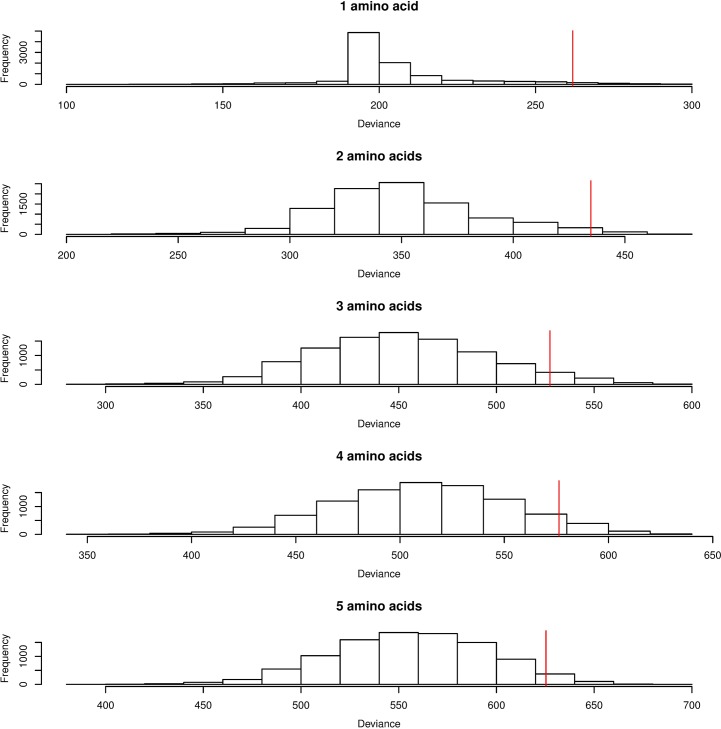
Empirical distribution of deviance in 10,000 permutations of amino acid sequences across classical HLA alleles.The vertical red lines indicate the deviances (261.89, 434.78, 527.37, 576.27, 625.34) explained by the top 1–5 amino acids in the actual data, which generate empirical P-values (0.0330, 0.0195, 0.0515, 0.0603, 0.0333) respectively.